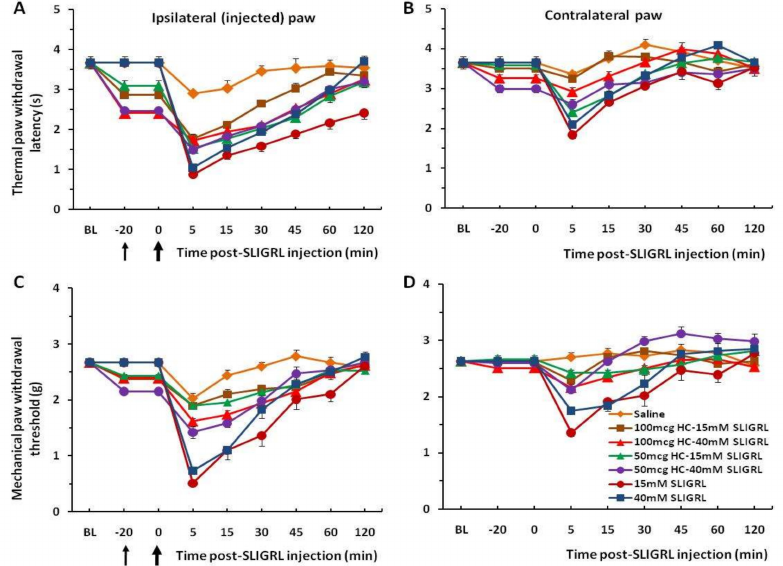
Figure 2. Dynamics of the thermal and mechanical withdrawals after HC-030031 pretreatment. Intra-plantar injection of SLIGRL results in a significant decrease of the thermal paw latency ( A ) and mechanical paw threshold ( C ), i.e., develops hyperalgesia. However, pretreatment with transient receptor potential ankyrin 1 (TRPA1) antagonist HC-030031 reduces these thermal and mechanical hyperalgesia, respectively. There are weaker mirror hyperalgesic e ff ects for the contralateral paw ( B , D ). Note, there was a significant di ff erence in the extent of inhibition between 50 mg and 100 mg HC-030031 for 15 mM SLIGRL at 30–60 min of the post-SLIGRL injection ( p < 0.001), but not for 40 mM SLIGRL ( p > 0.05) in the thermal test ( A ). The thin black arrow indicates the time of injection of HC-030031 and the bold arrow indicates the time of injection of SLIGRL. BL; pre-injection